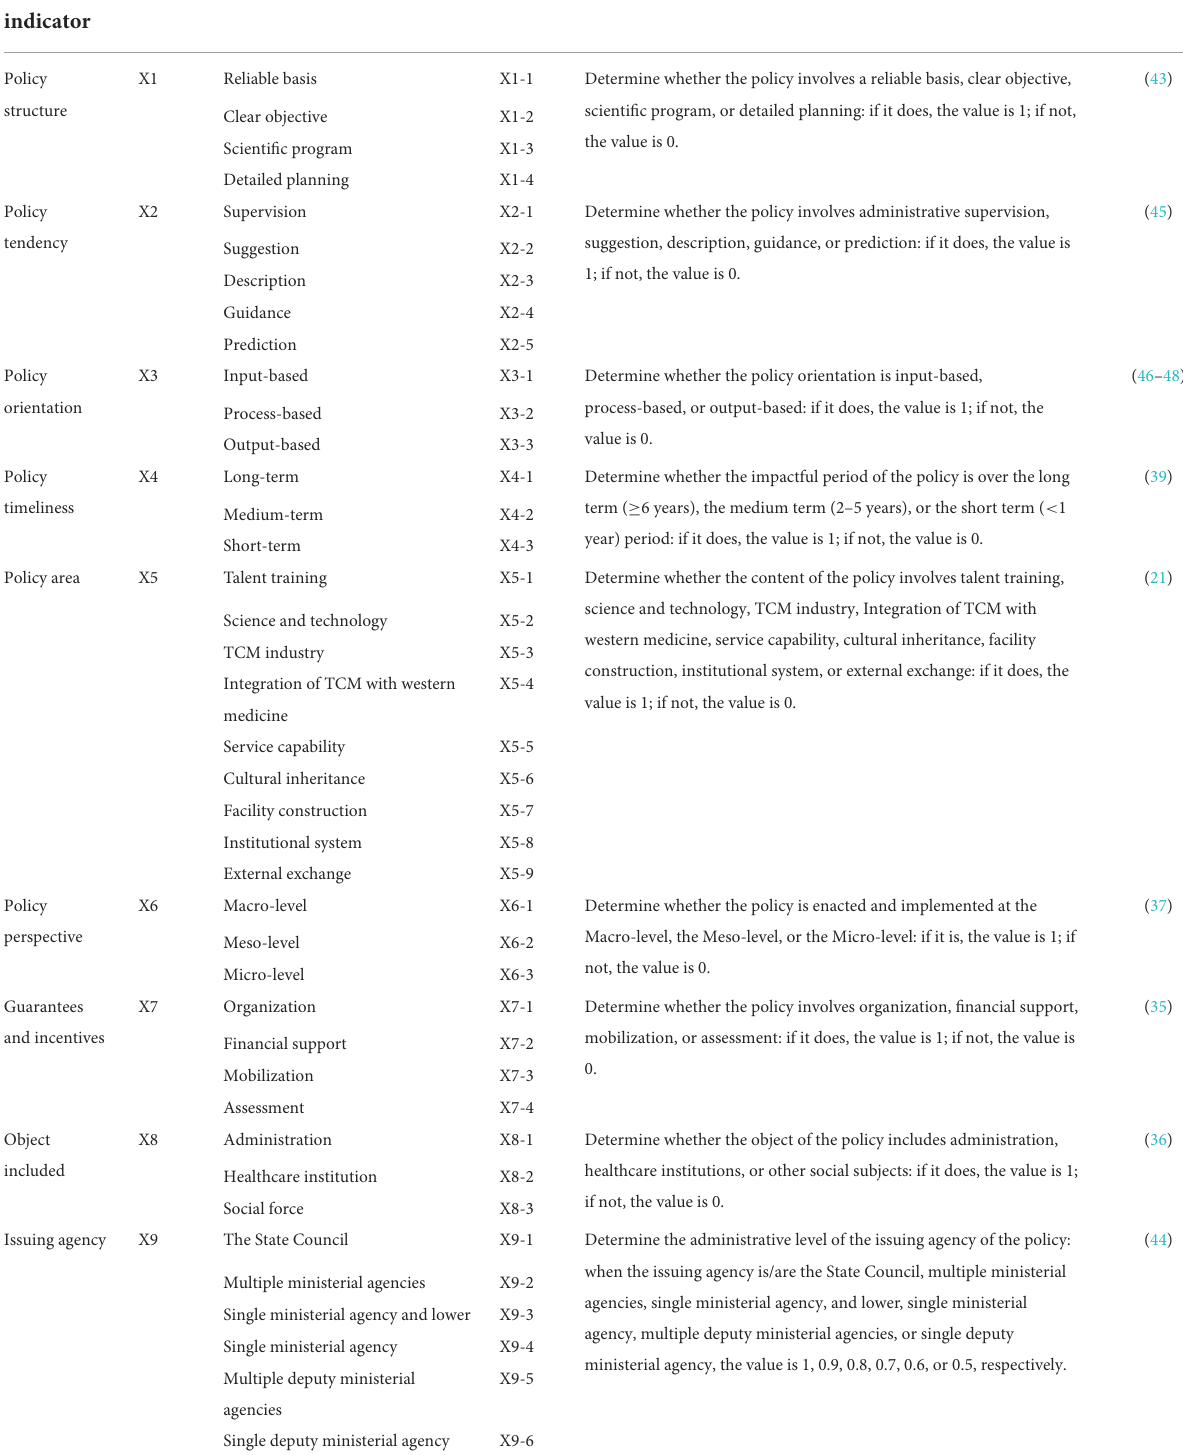
TABLE 2 Structure of the evaluation indicators system and criteria for the second-level